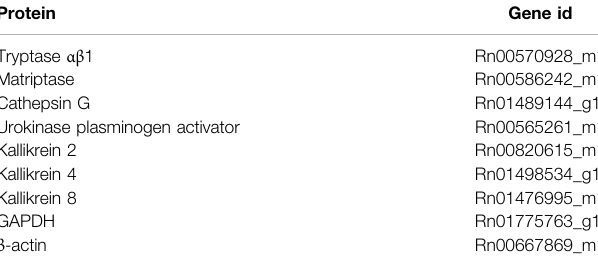
TABLE 1 | Taqman primers used for qPCR analysis of colonic samples.